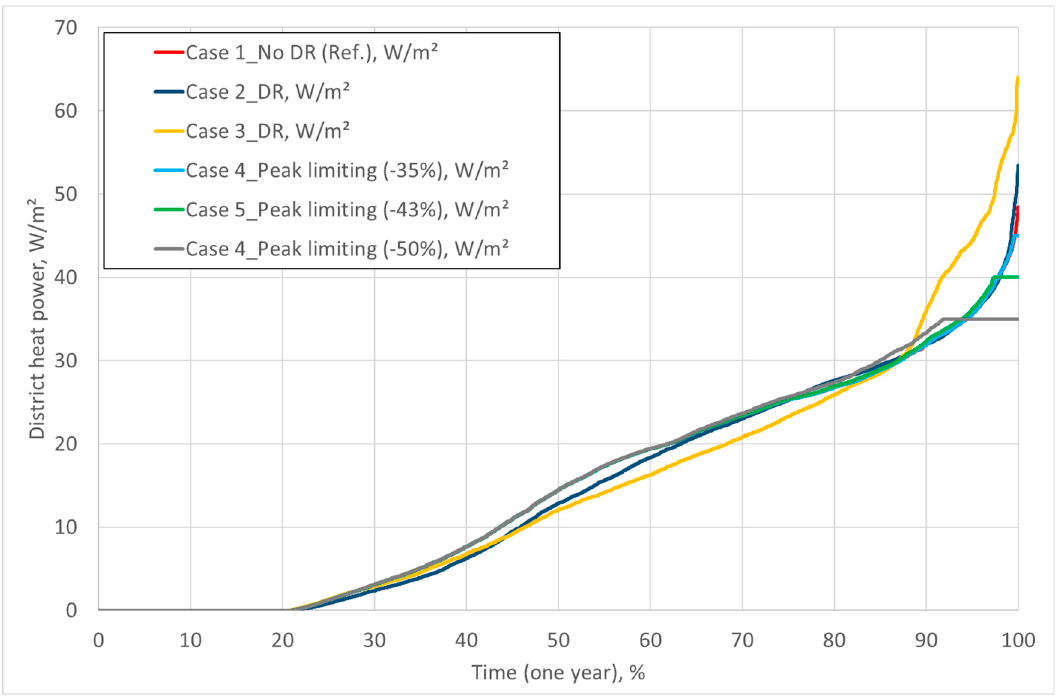
Figure 3. Duration of hourly DH power of space heating and ventilation per heated net floor area of the simulated example building with studied DR scenarios.